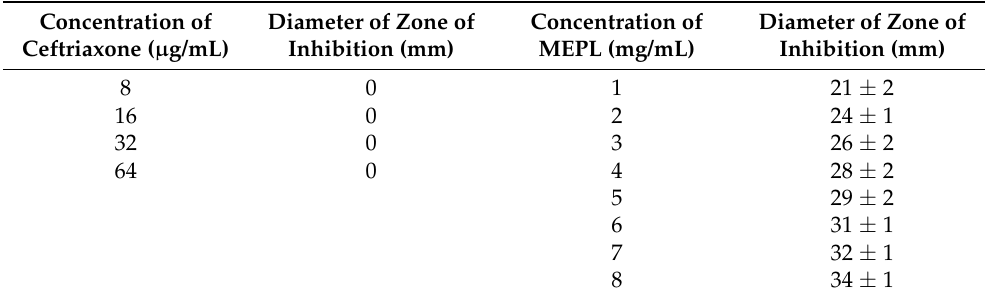
Table 1. Antimicrobial activity of MEPL against MRSA. Concentration